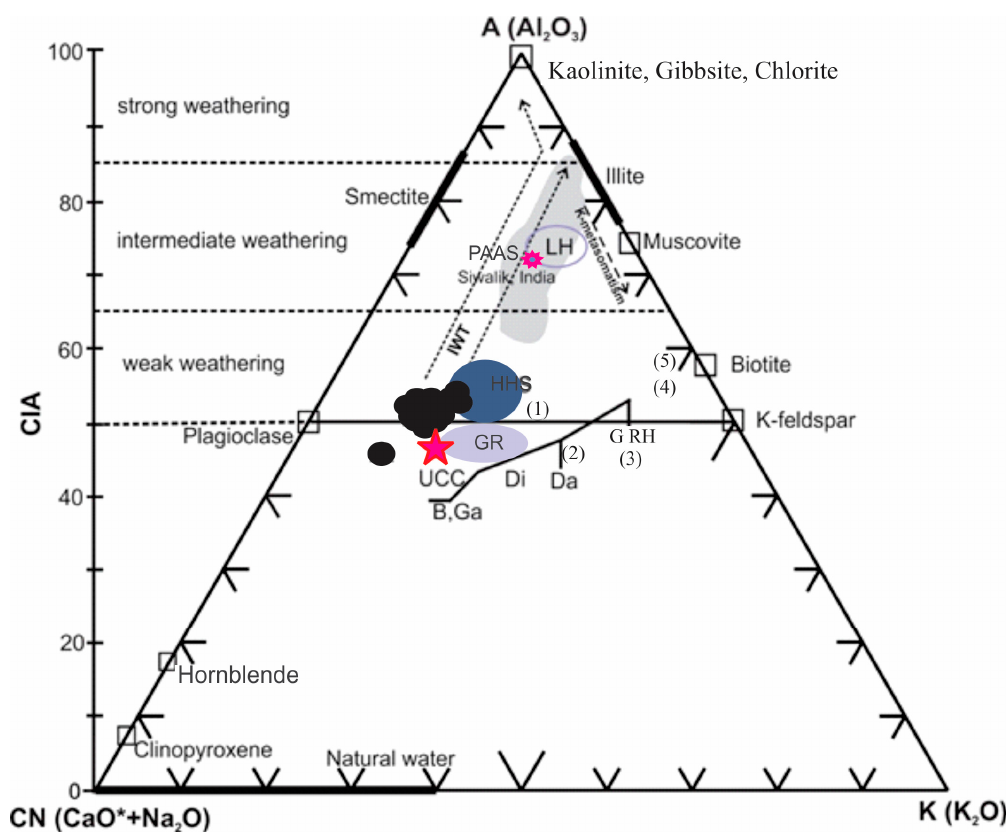
Figure 15. A–CN–K diagram with CIA values with vertical axis [60,63] for the Brahmaputra River sediments. Brahmaputra River sediment samples are represented by the black dots. CIA = Chemical Index of Alteration; IWT = Ideal Weathering Trend. Solid line linking crosses is the compositional trend in pristine average igneous rocks (data from Le Maitre [67]. B = basalt, Ga = gabbro, Di = diorite, Da = dacite, G = granite, Rh = rhyolite. Dashed line parallel to the A–CN edge is the ideal weathering trend (IWT). Himalayan source rocks for comparison: (1) Cretaceous granitoids (Trans ‐ Himalaya ‐ Ladakh [68]); (2) Trans ‐ Himalayan batholith [69]; (3) Tertiary leucogranite (Higher Himalaya [68]); (4) Paleozoic granitoids (Lesser Himalaya, Mandi ‐ granite [68]; (5) Baragaon mylonitic gneisses from the Lesser Himalaya, Garhwal, India [68]. Fields for the Siwalik Group, NW Himalaya, India [39], Higher and Lesser Himalaya source rocks (HHS and LH—[70]), Ganges River sediments (GR) [70], UCC and PAAS [30] are included for comparison.